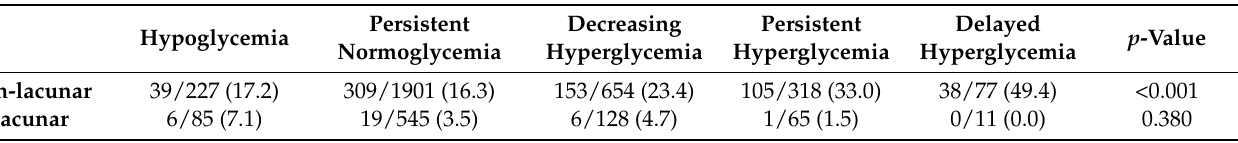
Table 2. Univariate association of categorical early glycemic trajectories with poor outcome by stroke